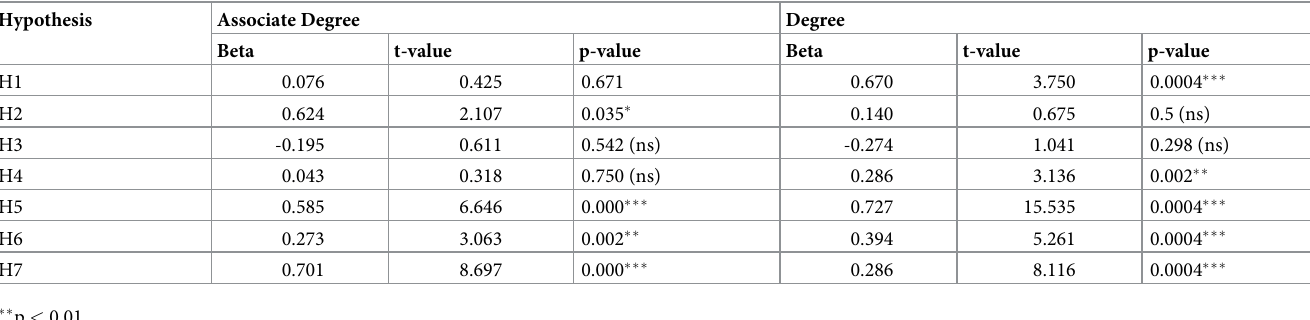
Table 6. Multi-group analysis (education